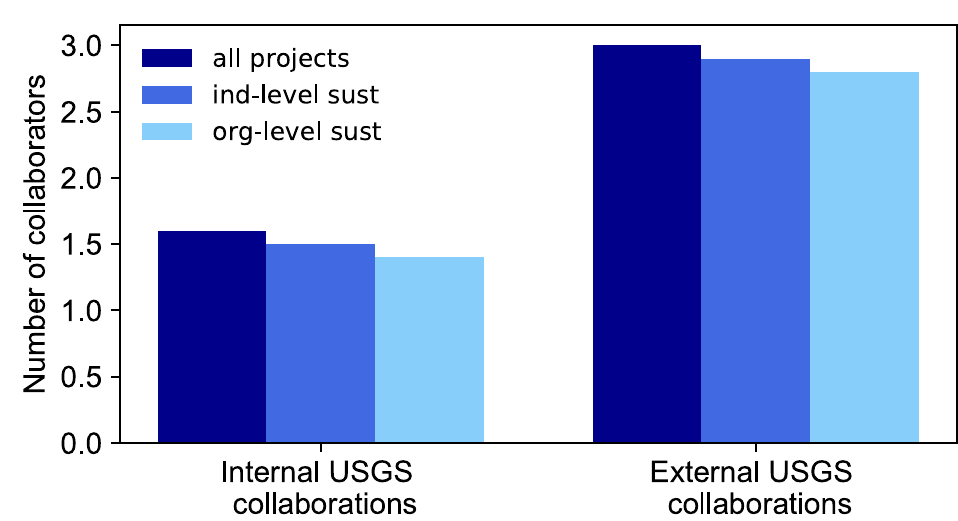
Fig 8. Average number of collaborating groups and level of sustainability. Compared to the pool of all projects (dark blue), projects that have achieved individual (medium blue) or organization-level (light blue) sustainability do not have greater numbers of internal or external